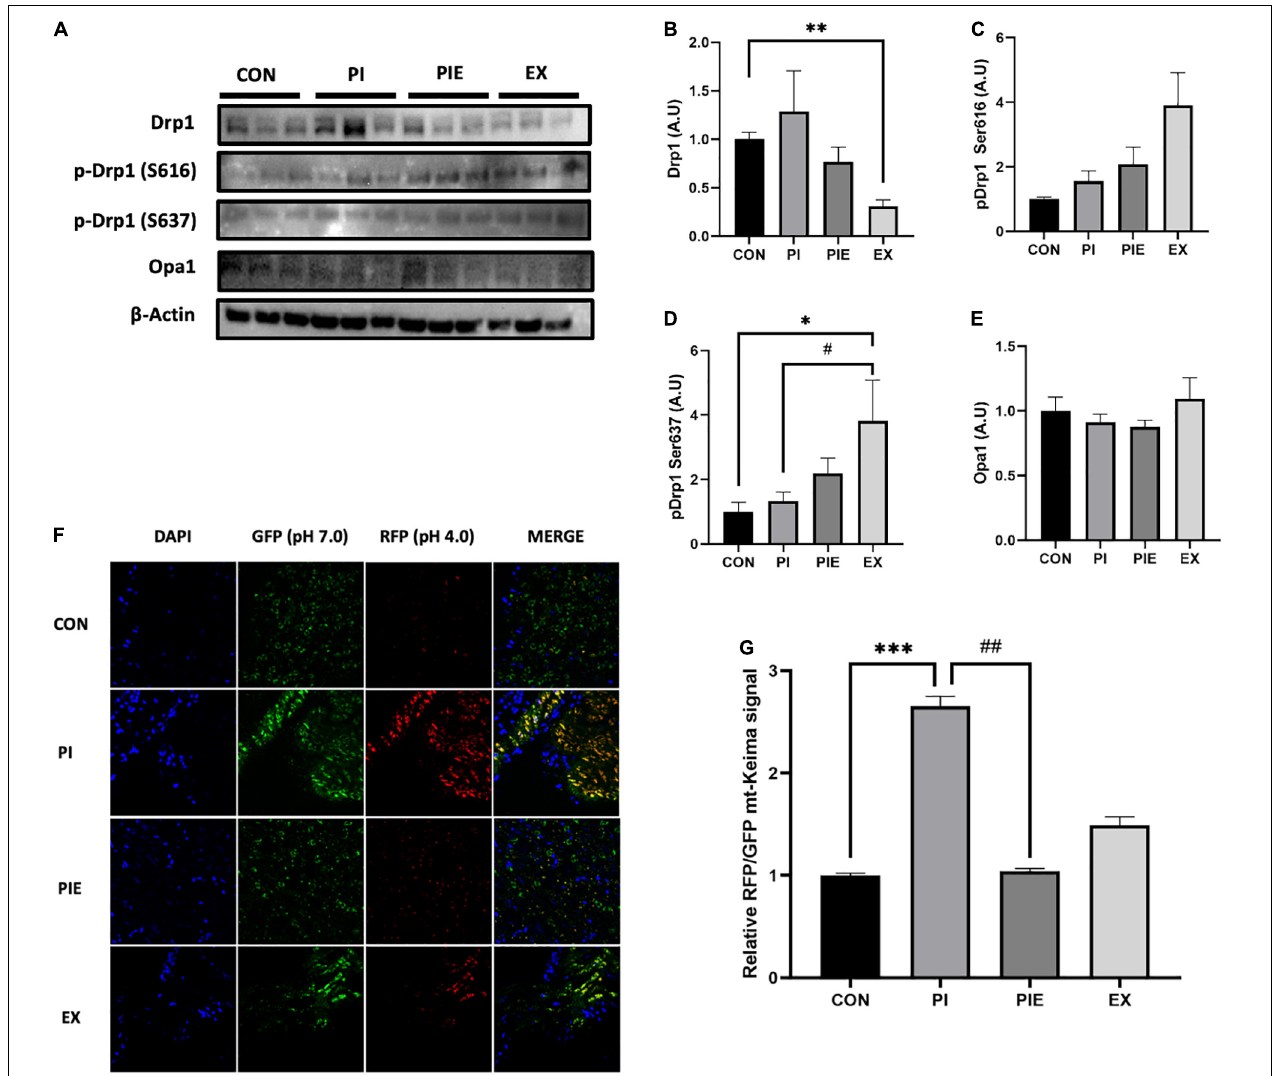
FIGURE 9 | PM exposure increased mitochondrial fission markers and in vivo mitophagy signals in the mt-Keima mice lung. (A) Representative western blot images of Drp1, p-Drp1 Ser616, p-Drp1 Ser637, and Opa1. Western blot analysis was performed to access the effect of PM exposure and exercise on Drp1 (B) , p-Drp1 Ser616 (C) , p-Drp1 Ser637 (D) , and Opa1 (E) . (F) Representative in vivo mitophagy in the lung of mt-Keima mice. (G) Assessment of the RFP/GFP ratio for mitophagy signals. Scale bar = 50 µ m. Values are the means ± SEM ( n = 6). ∗ P < 0.05 vs. CON, ∗∗ P < 0.01 vs. CON, ∗∗∗ P < 0.001 vs. CON, # P < 0.05 vs. PI, ## P < 0.01 vs.